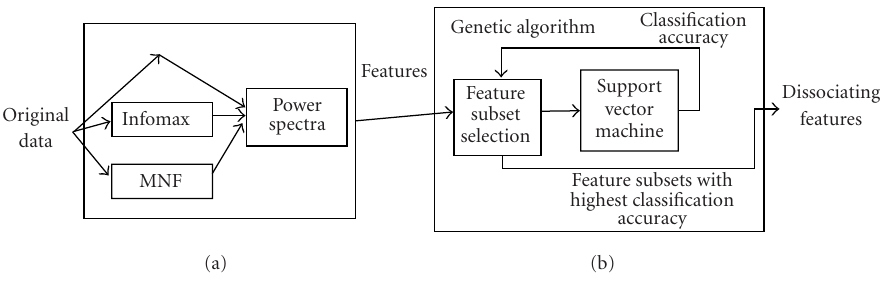
Figure 2: Feature selection system architecture. Three feature “families” were composed with parallel and/or series execution of signal trans- formations. Feature subsets are then evaluated with a support vector machine (SVM) classifier and the space of possible feature subsets searched by a genetic algorithm (GA) guided by the classification accuracy of the feature subsets. (a) Feature composition. (b) Feature selection. (Adapted from [12, Figure